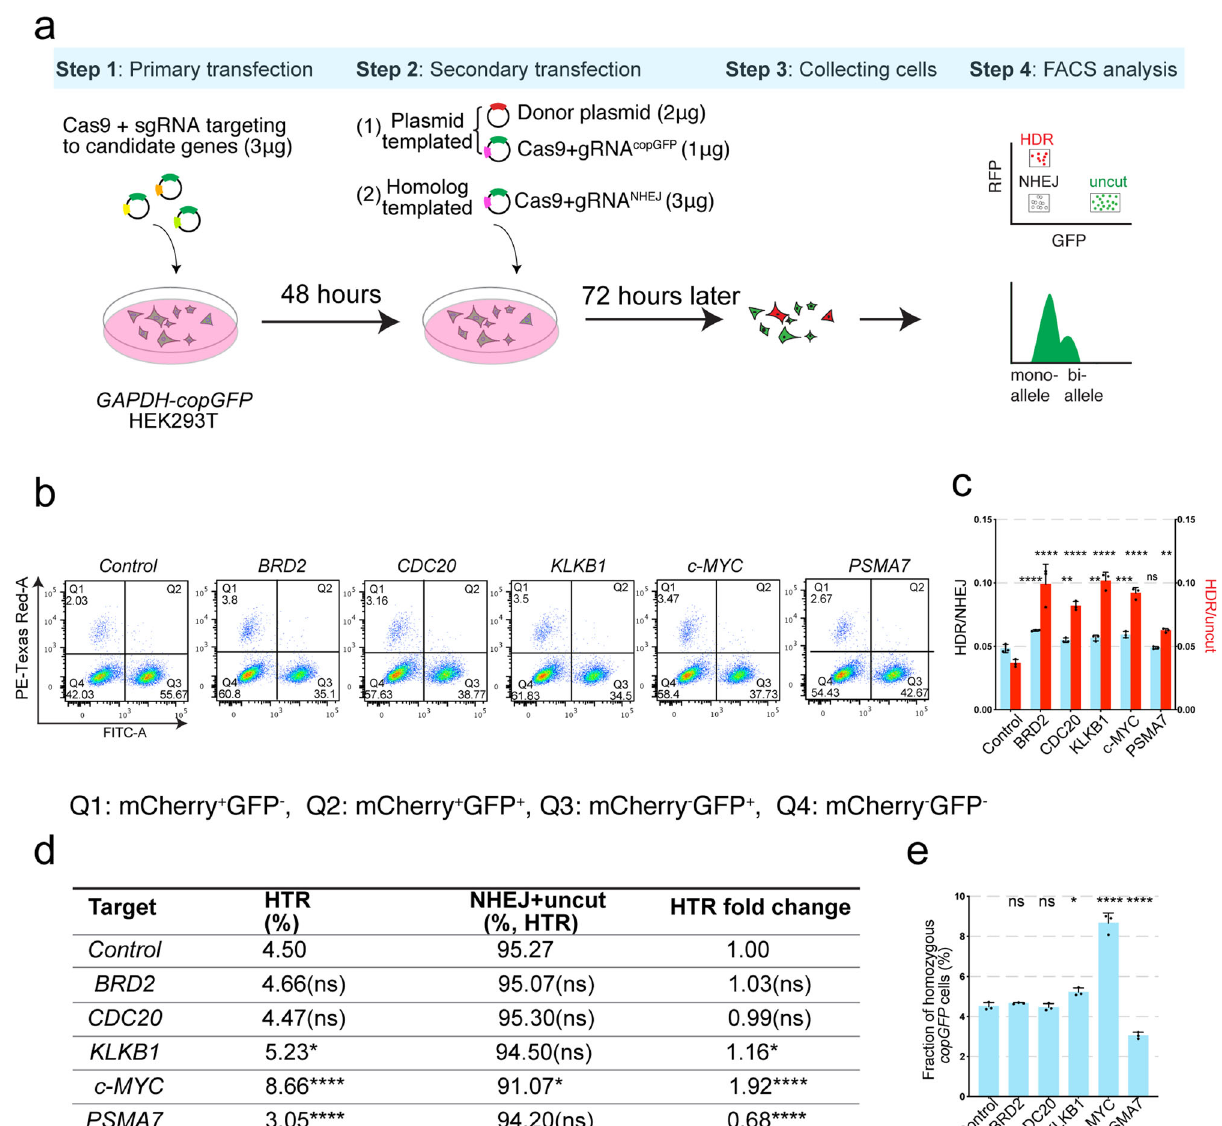
Fig. 4 Application of Drosophila SGC modi fi ers in mammalian cell lines. a Work fl ow for testing HDR rates resulting from RNAi knock-down of human orthologs of top hits modifying Drosophila SGC in human GAPHD-copGFP cells. Both exogenous plasmid and homologous chromosome templated somatic HDR were quanti fi ed with a GFP fl uorescent readout. Three biological replicates were conducted. b FACS plots with donor plasmid-mediated DSB